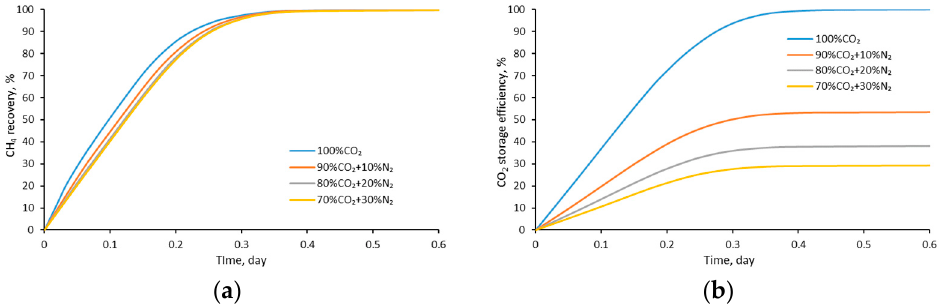
Figure 21. The variation curves under different CO 2 purity. ( a ) CH 4 recovery; ( b ) CO 2 storage efficiency.